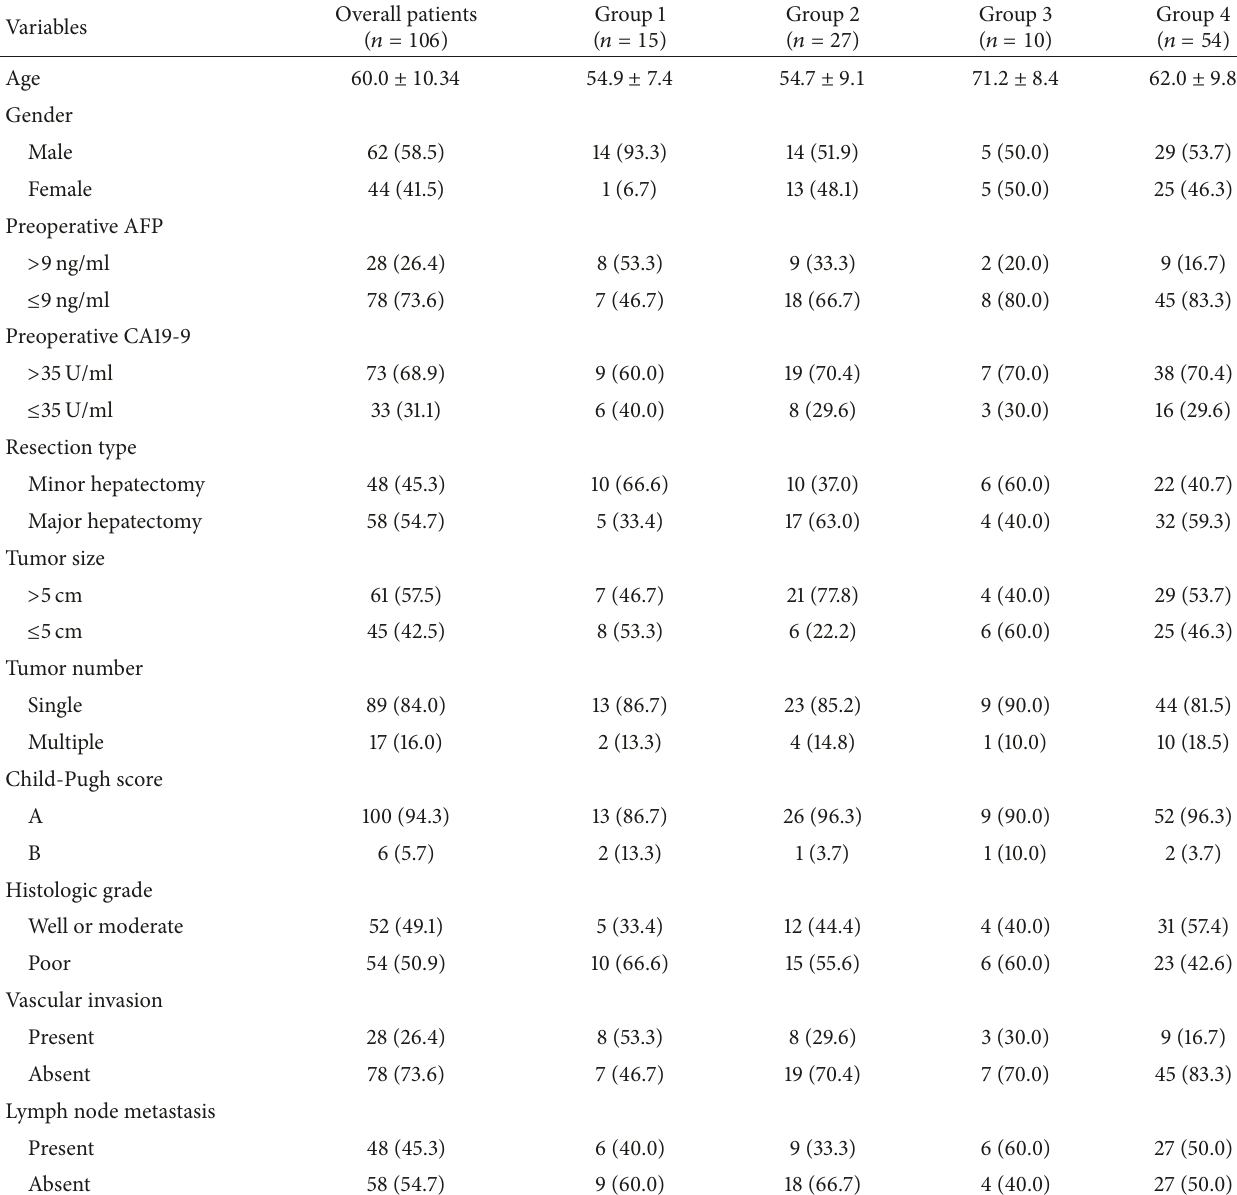
Table 1: Clinicopathological characteristics of the patients according to the presence of HBV infection and